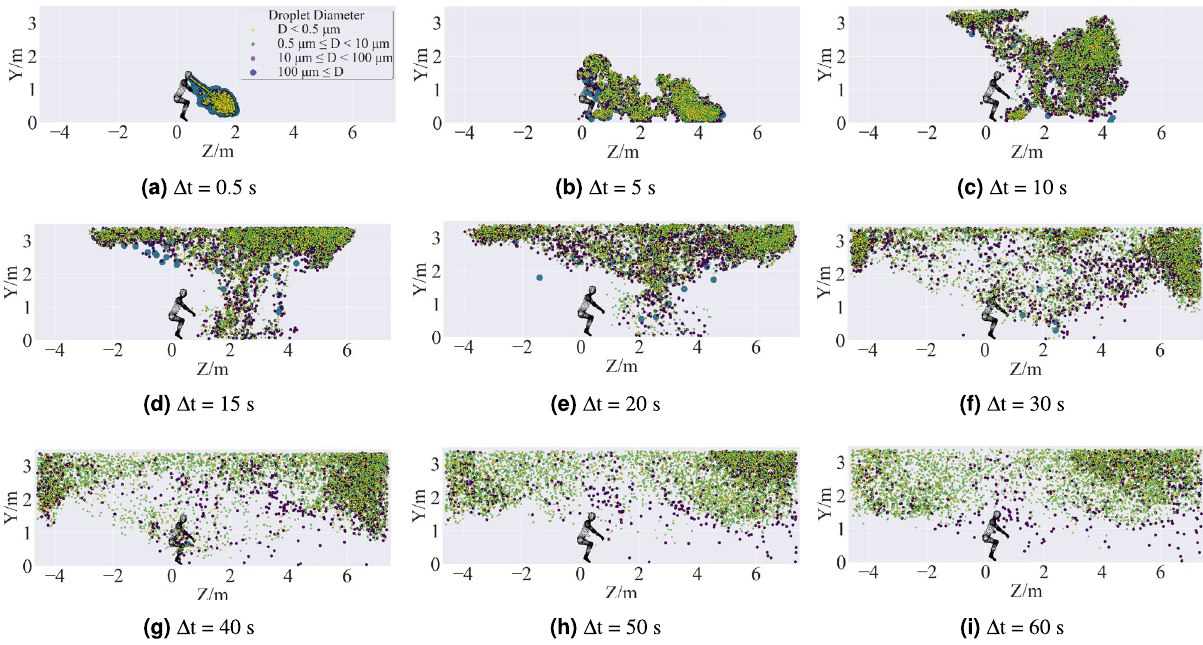
Figure 20. Side view of cumulative time distribution of droplet clouds in Case 1. The distributions of droplets were predicted by using the ANSYS Fluent (version 2019 R2). The figures were drawn by Matplotlib (version 3.5.0).